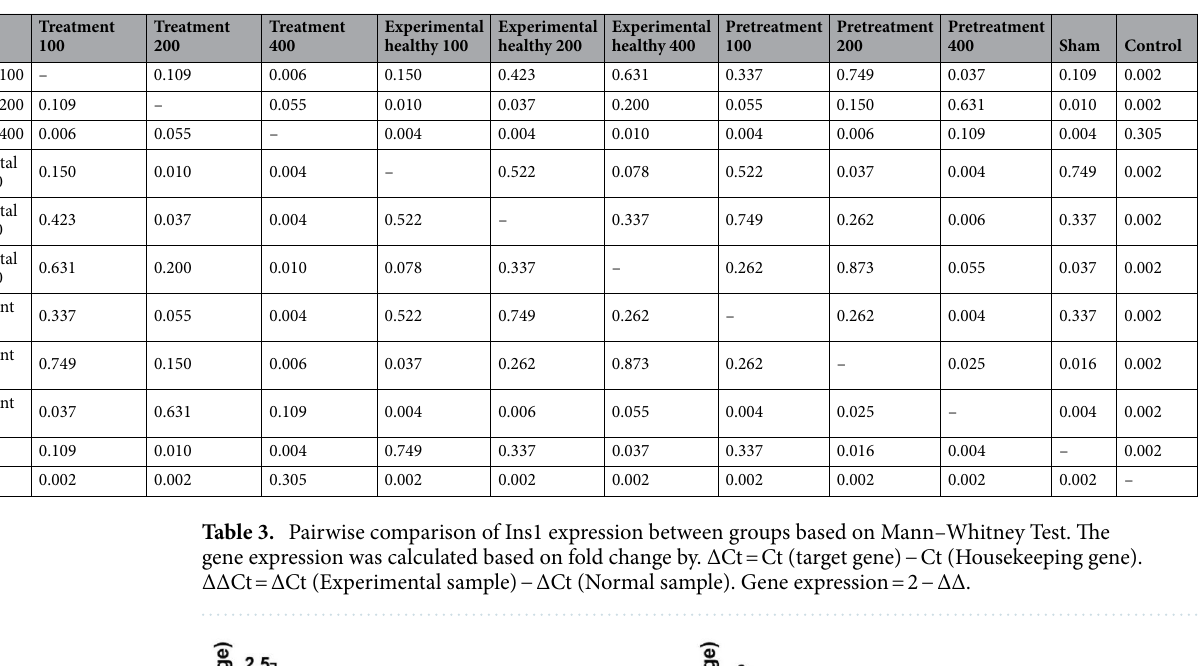
Table 2. Pairwise comparison of PDX1 expression between groups based on Mann–Whitney.